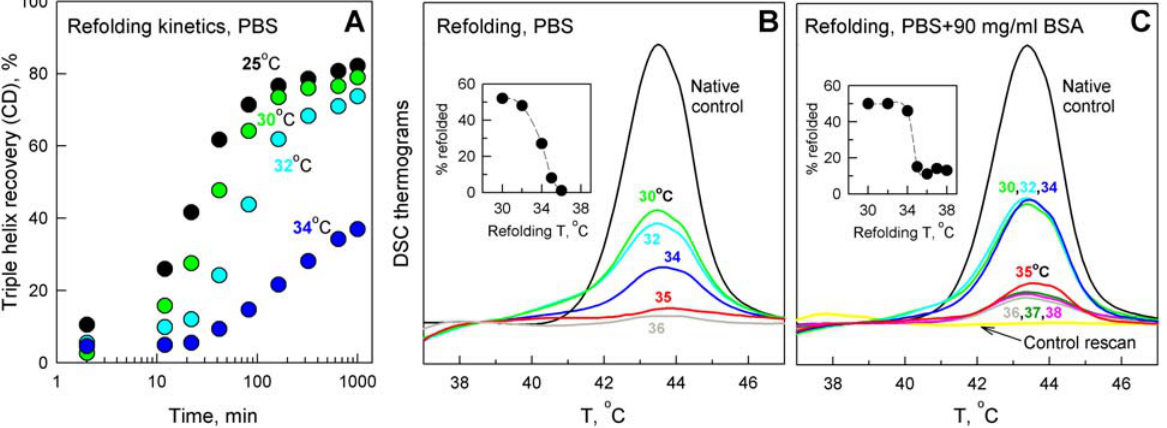
Figure 5. Procollagen triple helix spontaneously refolds below but not above 34 u C. A. Kinetics of 0.1 mg/ml procollagen refolding in PBS after 10 min denaturation of the triple helices at 45 u C (monitored by CD as in Fig. 4). B and C. Native triple helix refolding in PBS without (B) and with 90 mg/ml BSA (C) after an initial DSC scan from 25 to 50 u C at 1 u C/min. The fraction of refolded native procollagen (insets) was measured from the area under the DSC thermograms (colored tracings) after overnight equilibration in the DSC instrument at indicated temperatures following the initial denaturation scan (native control). A second scan without the overnight equilibration is shown by the yellow line in C.